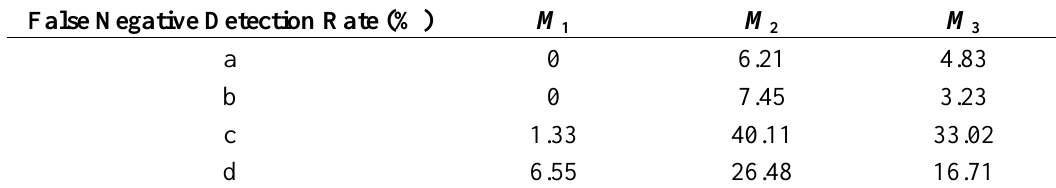
Table 4. Comparisons regarding the false negative detection